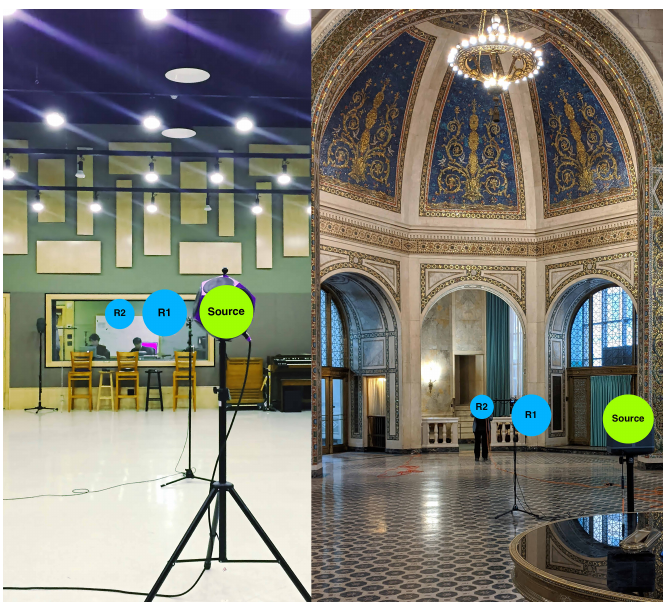
Figure 4. Comparison of analogous source-receiver proxemics between the two historical case-study sites: source (omnidirectional loudspeaker; green circles) and receiver (omnidirectional microphone; blue circles labeled R1 and R2) locations in Columbia Studio A (CSA), Nashville, TN, USA ( left ) and the Rochester Savings Bank (RSB), Rochester, NY, USA ( right ). Laser-measured distances from each source to its receivers labeled in each room are 3 and 6 m (CSA) and 6 and 14 m